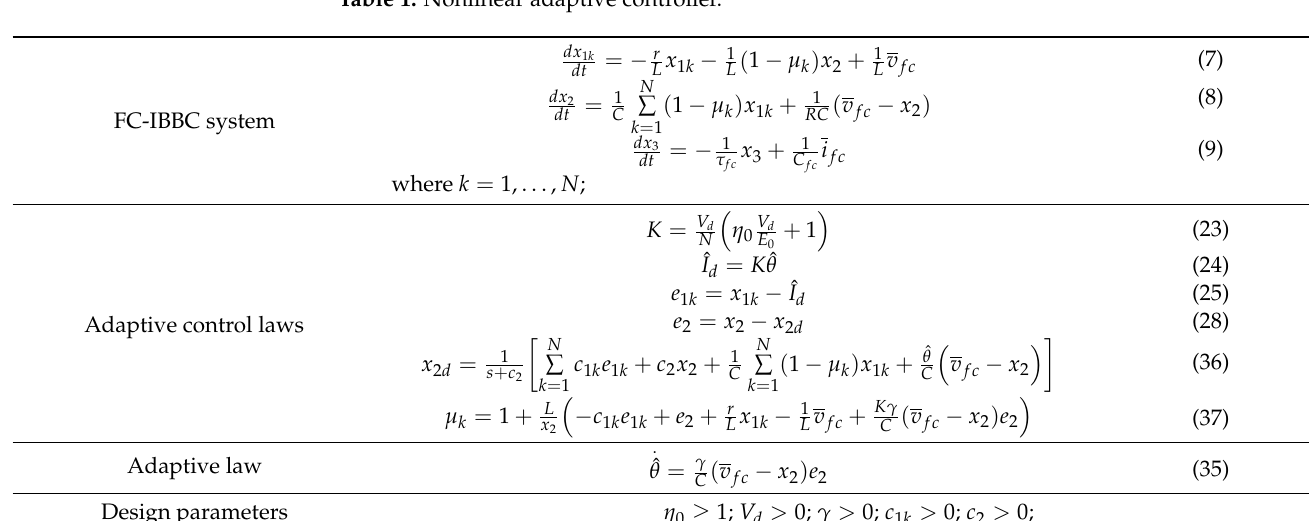
Table 1. Nonlinear adaptive controller.